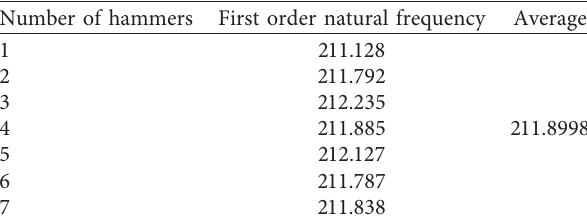
Figure 8: Hammer test: (1) 5-order mode shape; (2) transfer function curve. Table 2: Statistics of first-order natural frequency of the vehicle- ground system (unit: Hz).